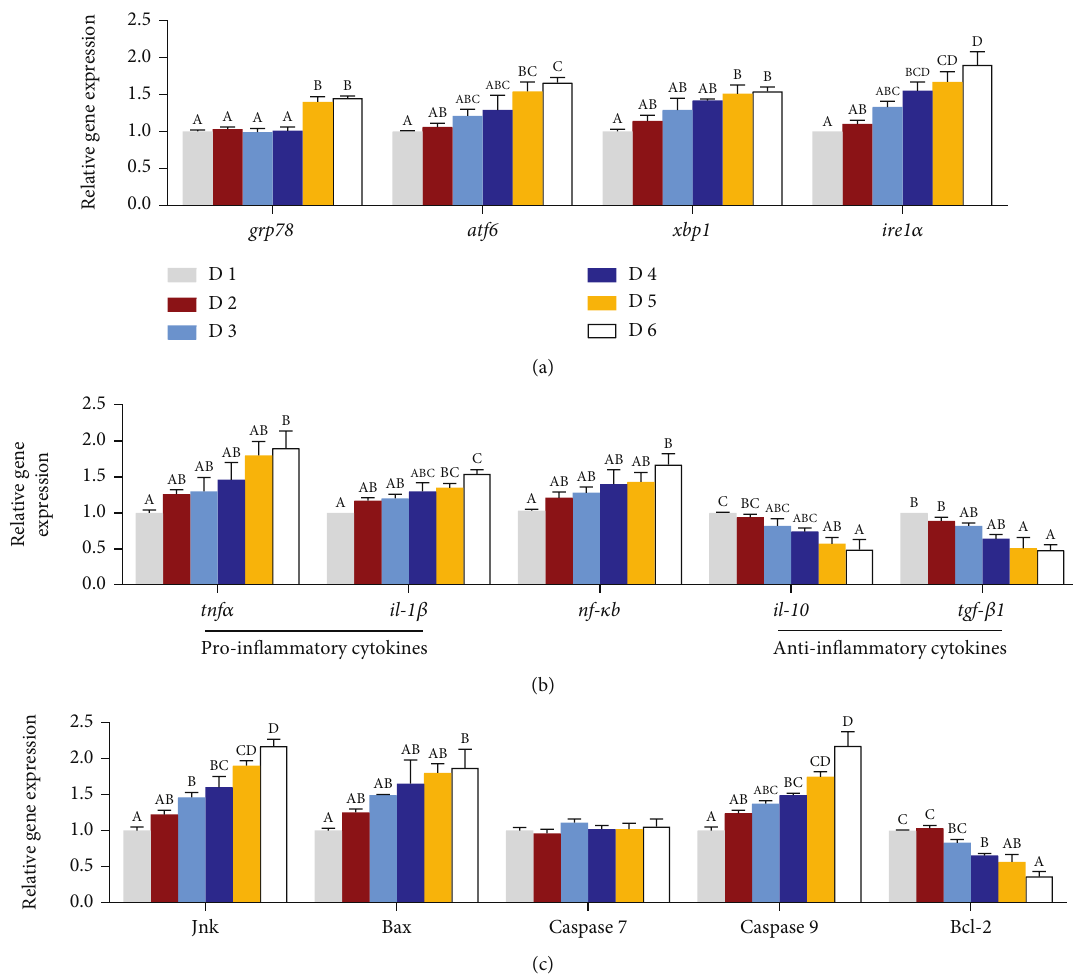
Figure 7: E ff ects of dietary lipid levels on the related gene expressions of endoplasmic reticulum stress (a), in fl ammatory responses (b), and apoptosis (c) in the liver of juvenile Acanthopagrus schlegelii reared at low-salinity water. Values are means ( n = 3 ), with standard errors represented by vertical bars. Mean values for the same column with di ff erent superscript letters were signi fi cantly di ff erent ( P < 0 : 05 ). atf6 : activating transcription factor 6; grp78 : glucose regulated protein 78; ire1 ɑ : inositol requiring enzyme-1 ɑ ; xbp1 : X-box binding protein 1; il-10 : interleukin-10; il-1 β : interleukin-1 β ; nf- κ b : nuclear factor kappa B; tgf β : transforming growth factor β ; tnf α : tumor necrosis factor α ; bax : bcl2-associated X; bcl-2 : B cell leukemia 2; jnk : c-Jun N-terminal